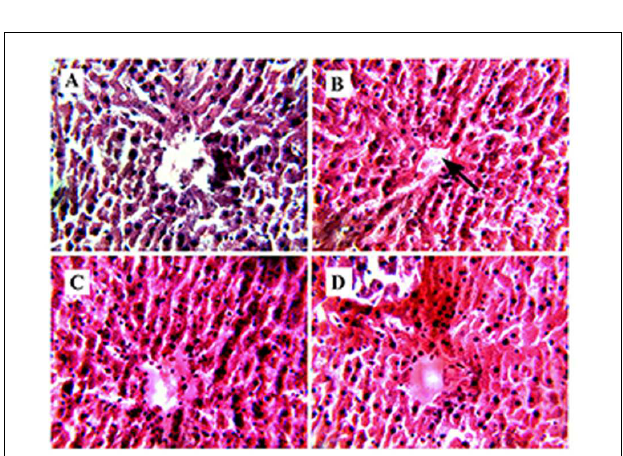
FIGURE 4 | Congested central vein. (B) Represents Hematoxylene Eosine staining of STZ induced liver section, showing congestion in central vein (represented by arrow). (A) represents normal sized central vein. (C) It is the RE (100 mg/kg) treated liver section, showing improvement in the hepatic cell structure and (D) represents glibenclamide (10 mg/kg) treated liver section, showing development in the hepatic structure.